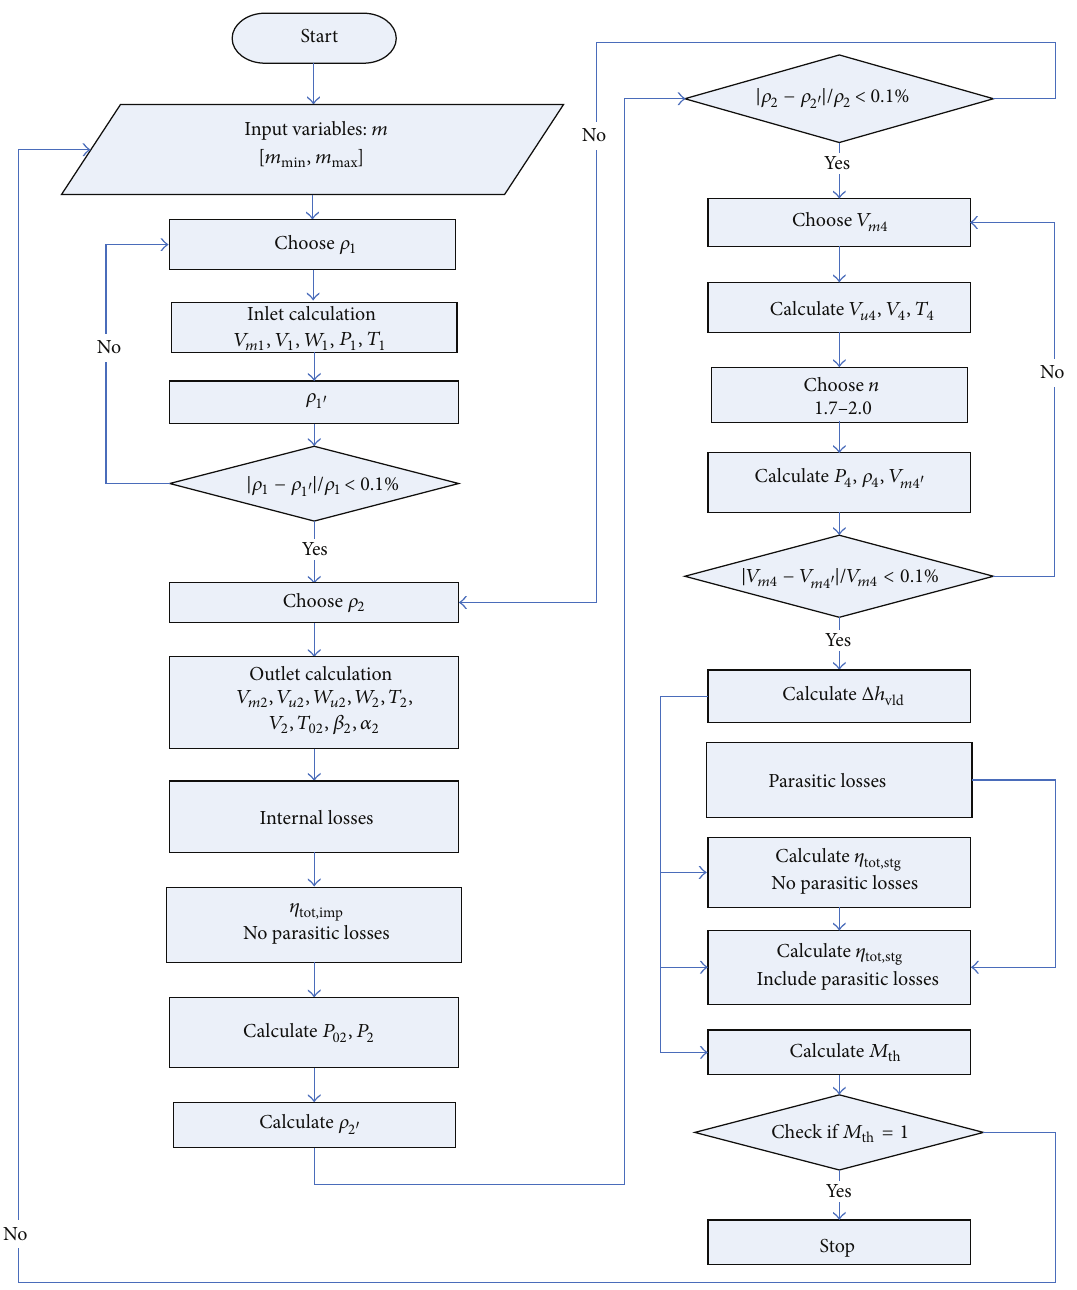
Figure 3: Detailed flow chart of 1D analysis